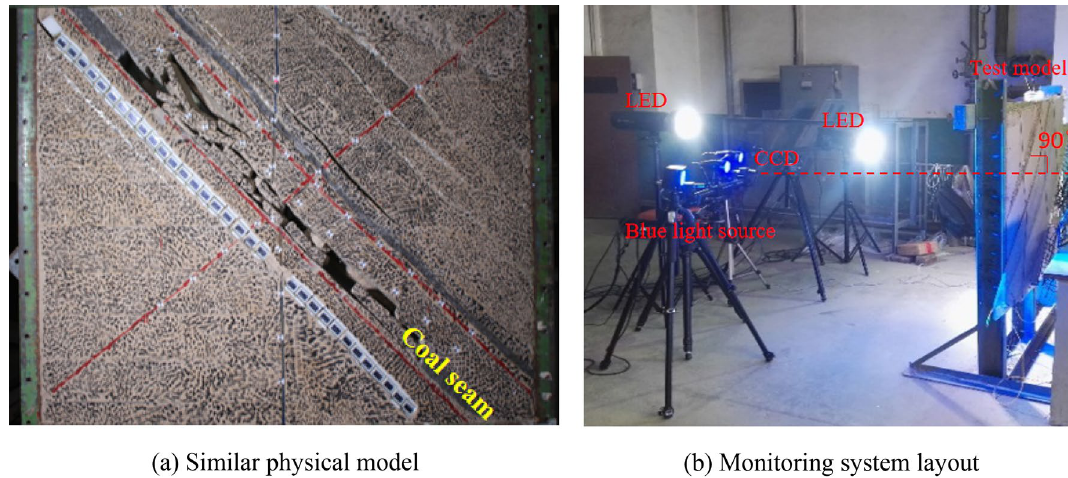
Figure 10. Two-dimensional similar physical model and